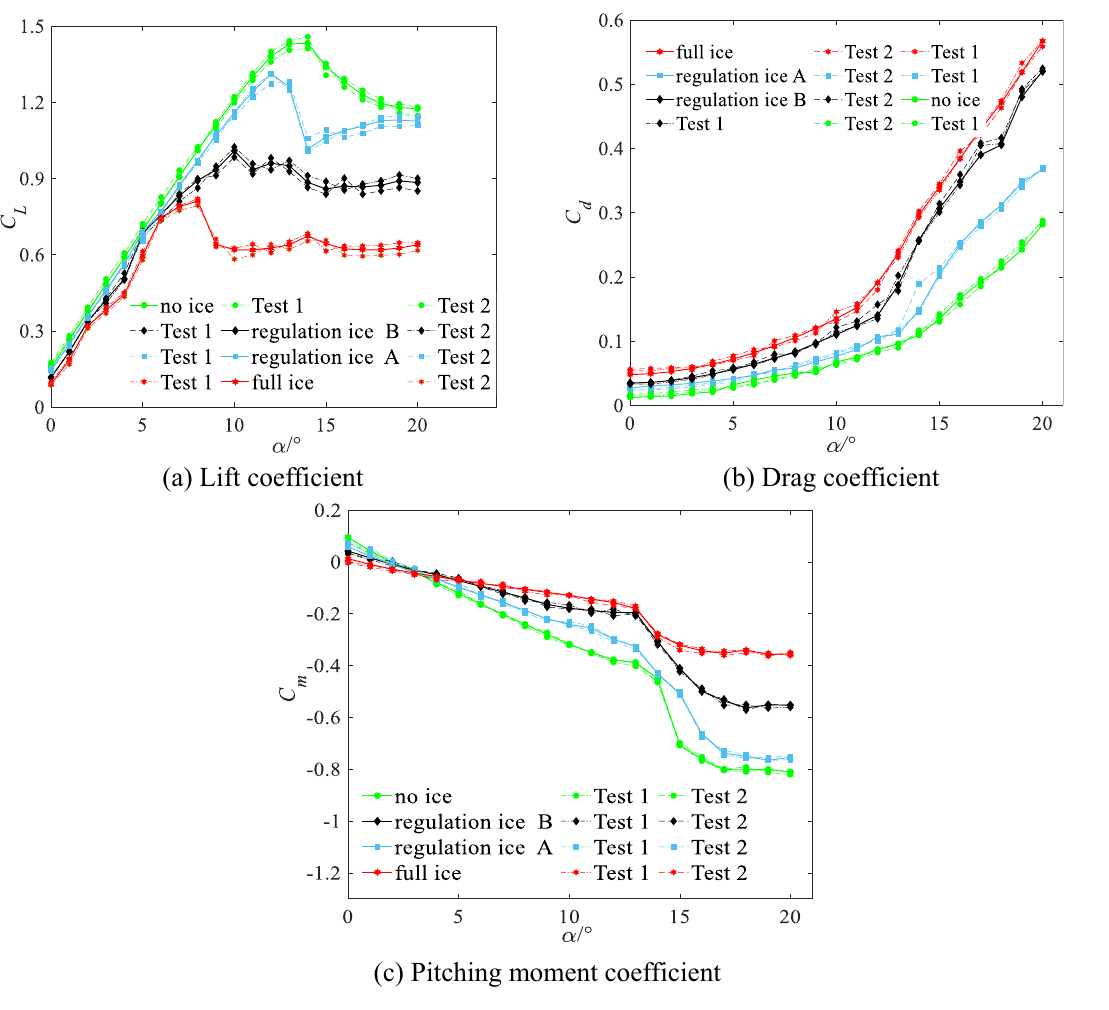
Figure 9. C L , C d , C m of background aircraft under four states.